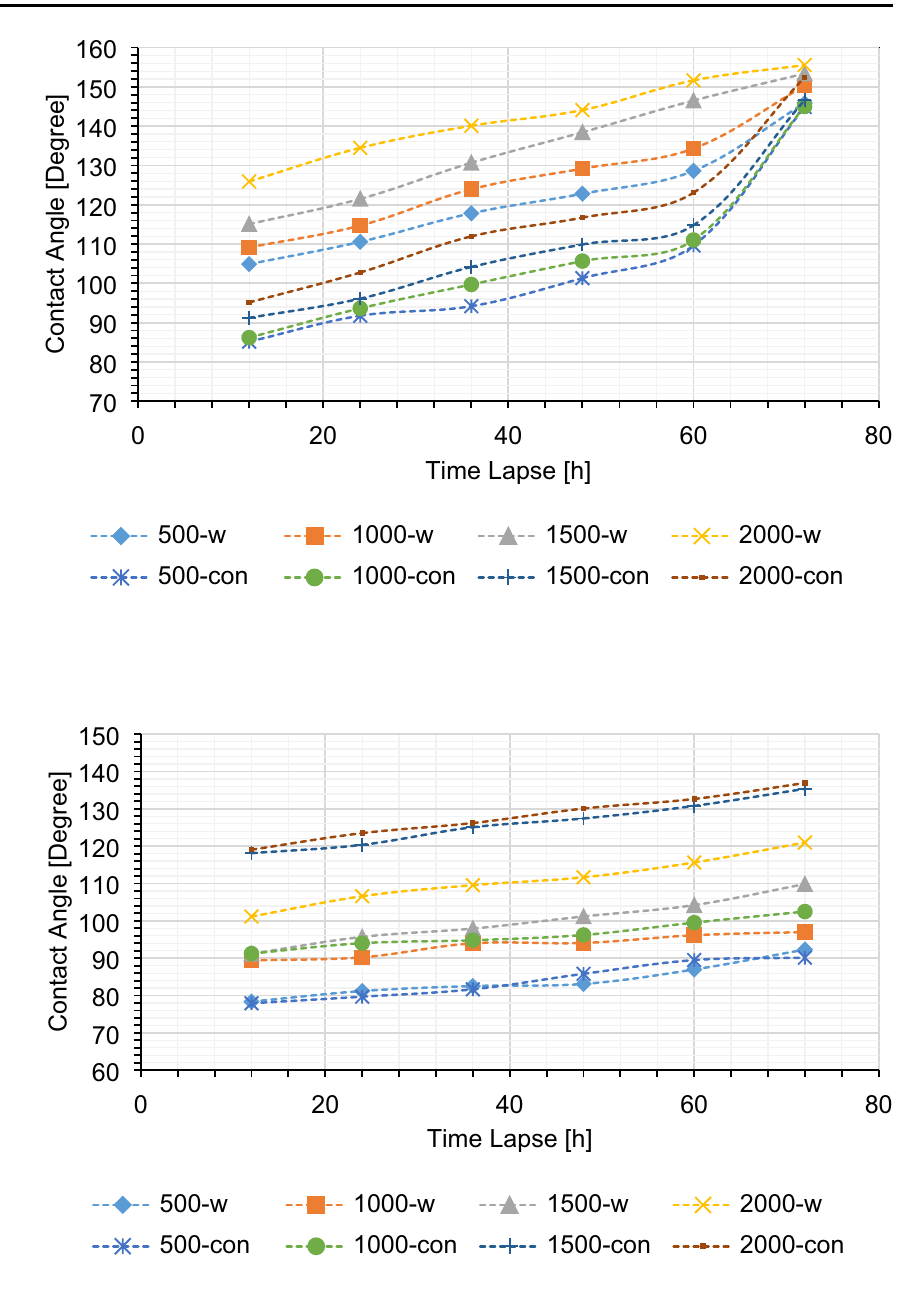
Fig. 7 The obtained curves from the contact angle experi- ments due to the droplet of water and condensate in the presence of the air on the aged carbonate sections of R404A gas at 70 °C and different pres- sures of aging duration